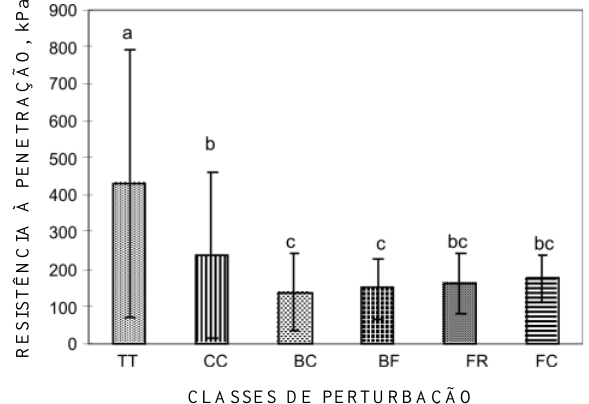
Figura 3. Valores médios e desvios-padrão da resistência à penetração (kPa) em diferentes classes de perturbação (0–3 cm) (TT-trilha do trator; CC-centro da clareira; BC-borda da clareira/floresta; BF-borda da floresta/clareira; FR-floresta remanescente e FC-floresta- controle). Barras (médias) acompanhadas de mesmas letras não diferem entre si, pelo teste de Tukey a 5 %.